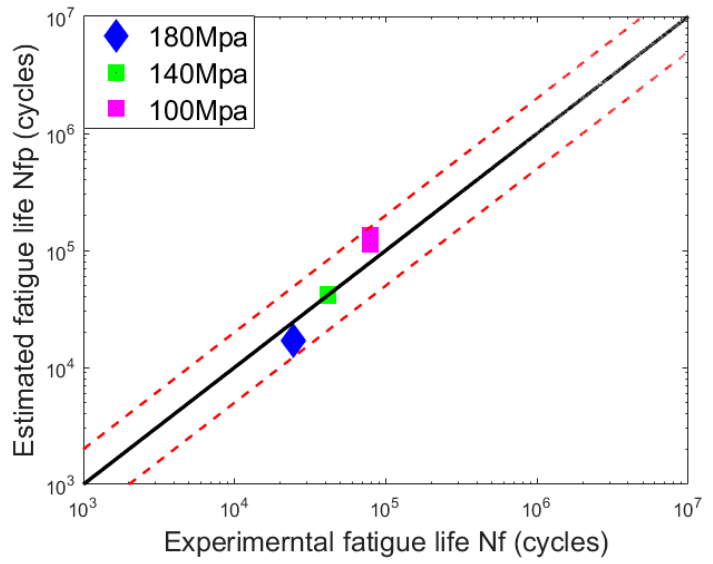
Figure 15. Fatigue life prediction of dissimilar lightweight materials welded joints from continuum damage mechanics method.